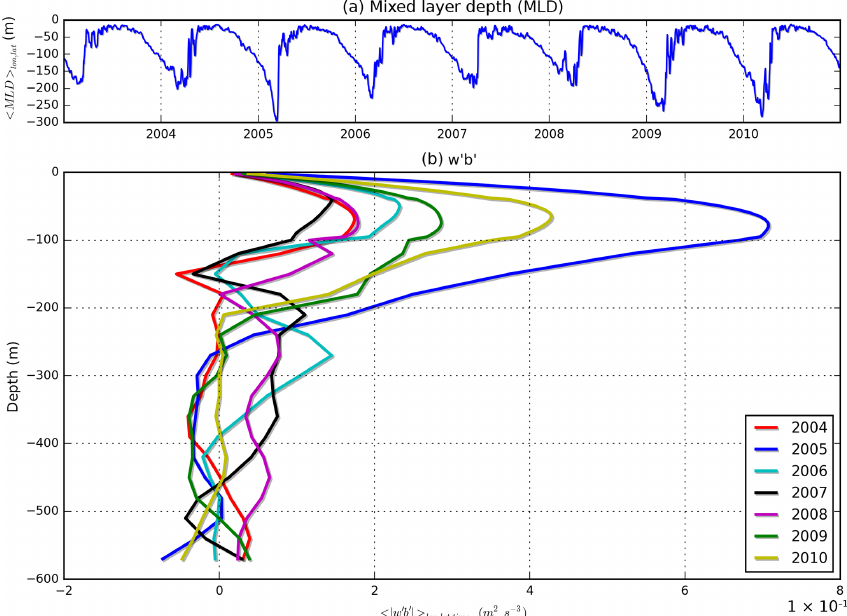
Figure 16. (a) Averaged mixed layer depth in the studied region (Fig. 9). (b) Vertical profiles of w (cid:48) b (cid:48) averaged over the same domain during winter seasons (January–February–March).